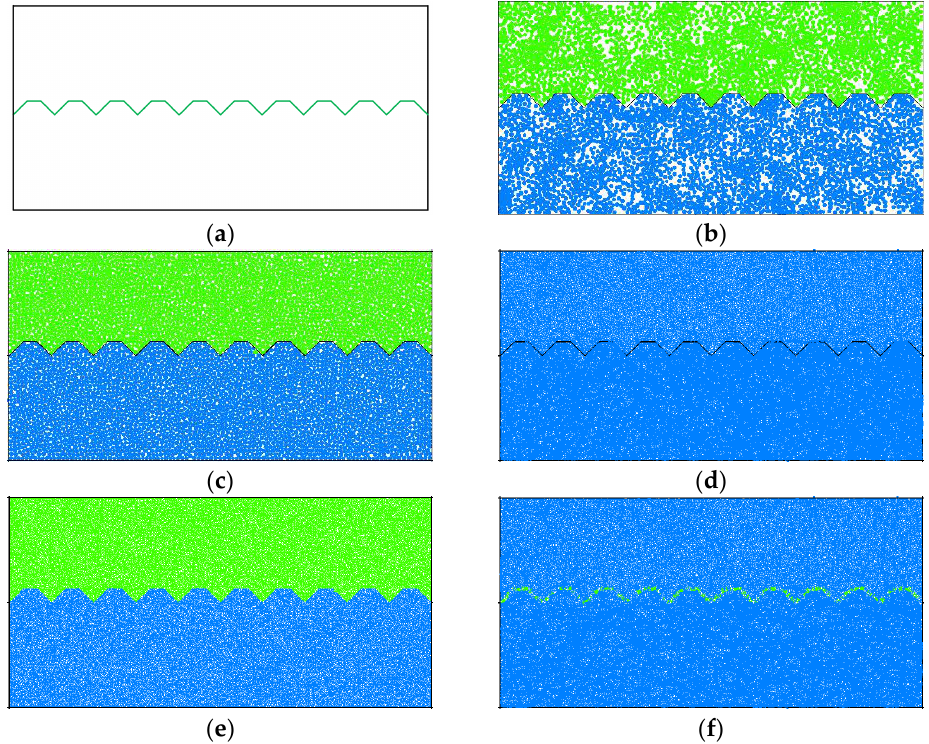
Figure 1. Procedure of shear box genesis: ( a ) material vessels generation; ( b ) initial assembly generation; ( c ) static equilibrium; ( d ) parallel bond installation; ( e ) remove interface walls; ( f ) applying smooth joints.